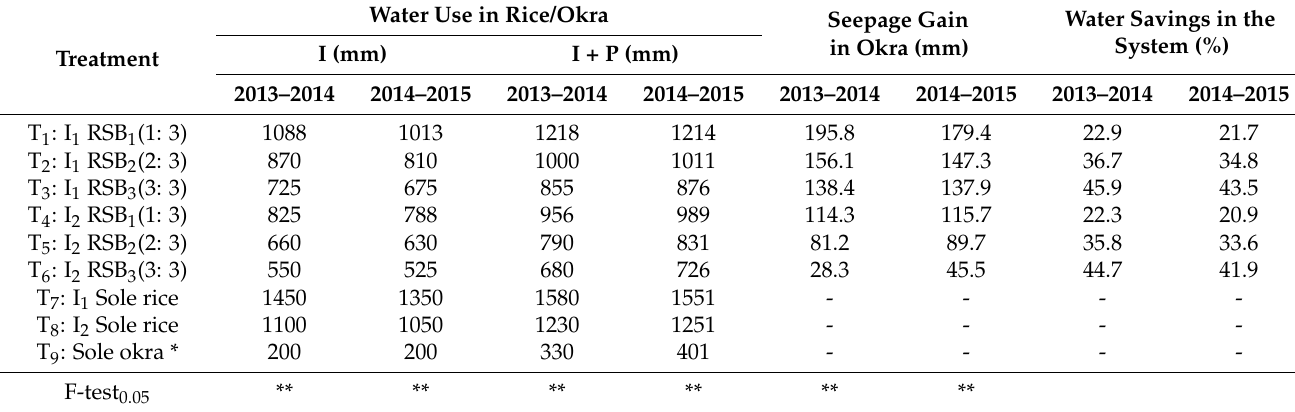
Water Savings in in Okra (mm)